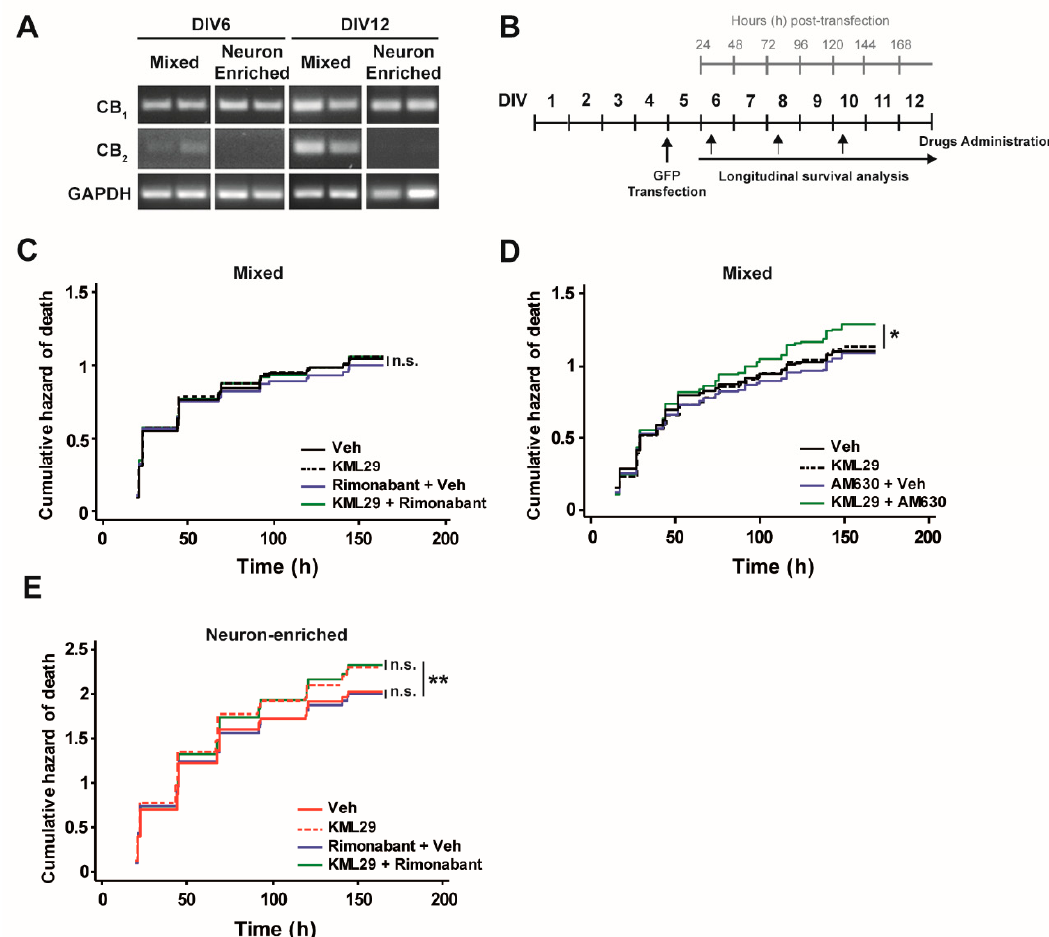
Figure 4. Role of cannabinoid type 1 (CB1) and CB2 receptors blockage on monoacylglycerol lipase inhibition (MAGL) inhibition-dependent neurotoxic e ff ect. ( A ) Analysis of CB1 and CB2 receptors expression by PCR in mixed and neuron-enriched primary cultures at DIV6 and at DIV12 (GAPDH as reference gene). ( B ) Experimental design: 10 µ M AraC was added at DIV2 for 48 h to prevent cell proliferation. Mixed ( − AraC) and neuron-enriched ( + AraC) cultures were transfected at DIV5 with GFP and treated with compounds (250 nM KML29, 200 nM Rimonabant, 1 µ M AM630 or vehicle), starting at DIV6 every 48 h. Longitudinal tracking using automated microscopy of individual rat cortical neurons was performed every 24 h after transfection. ( C ) Cumulative hazard estimates of GFP-transfected neurons from mixed ( − AraC) neuronal cultures treated with KML29, Rimonabant or both (vehicle as control) (Log-rank test n = 650–950 neurons per condition from 3 independent experiments. ( D ) Cumulative hazard estimates of GFP-transfected neurons from mixed ( − AraC) neuronal cultures treated with KML29, AM630 or both (vehicle as control). Log-rank test, n = 530–840 neurons per condition from 4 independent experiments. ( E ) Cumulative hazard estimates of GFP-transfected neurons from enriched neuronal cultures ( − AraC) treated with KML29, Rimonabant or both (vehicle as control). Log-rank test, n = 1170–1550 neurons per condition from 3 independent experiments.